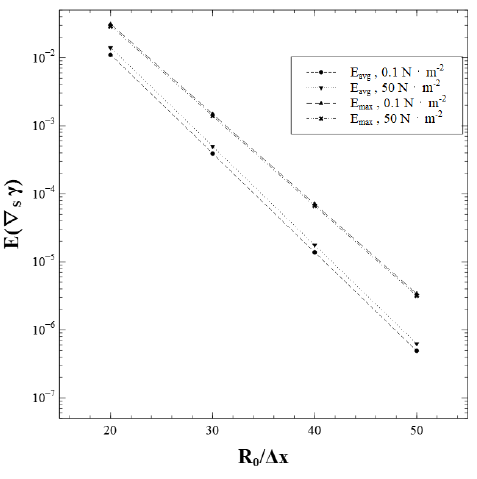
Figure 14. Relative error of the surface tension gradient as a function of mesh